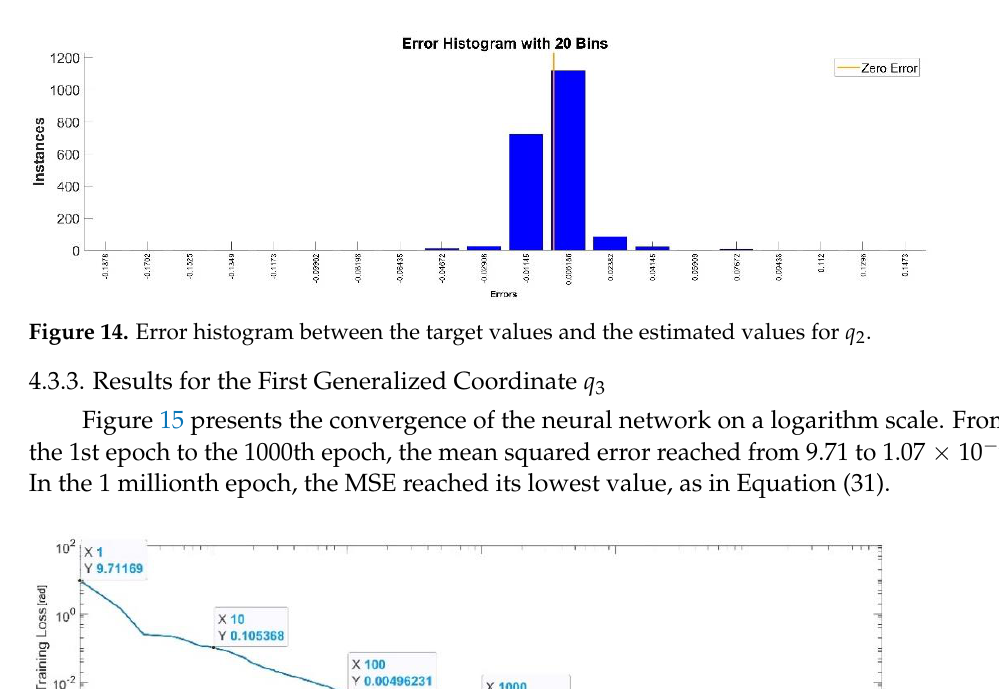
Figure 13. Relative errors between the target values and the predicted values for 𝑞 2 .